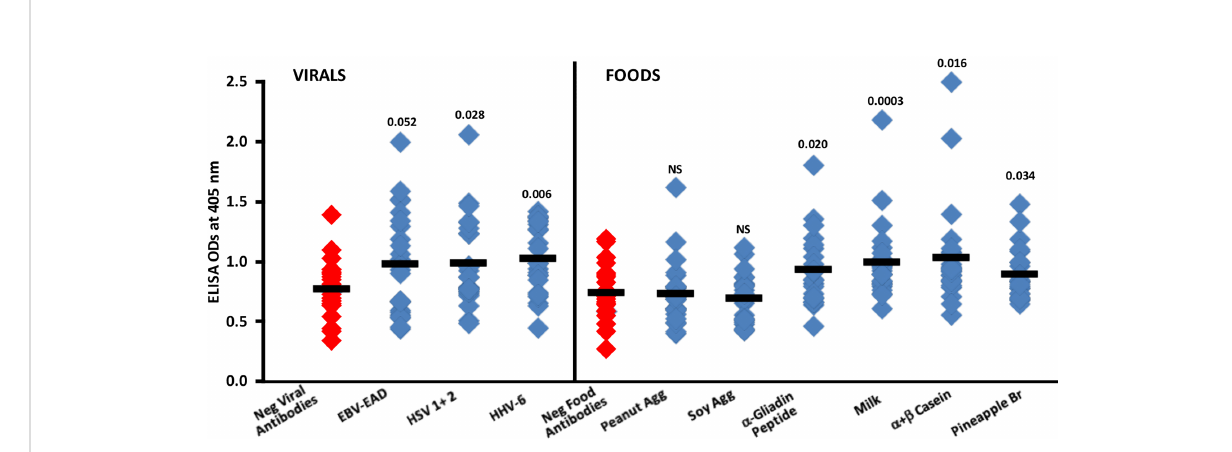
FIGURE 8 Reaction of human sera with low (Negative) or high levels of IgG antibody against EBV-EAD, HSV 1 + 2, HHV-6 and different food antigens with SARS-CoV-2 spike protein-coated plates. Black bars =